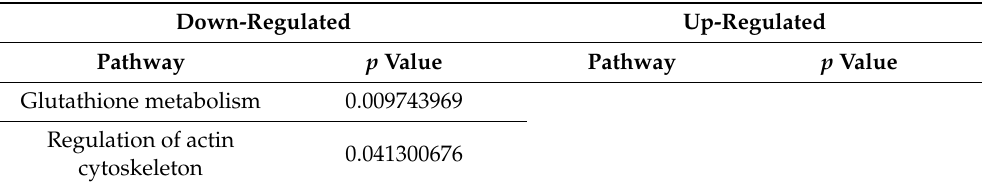
Table 5. Down-regulated and up-regulated pathways.